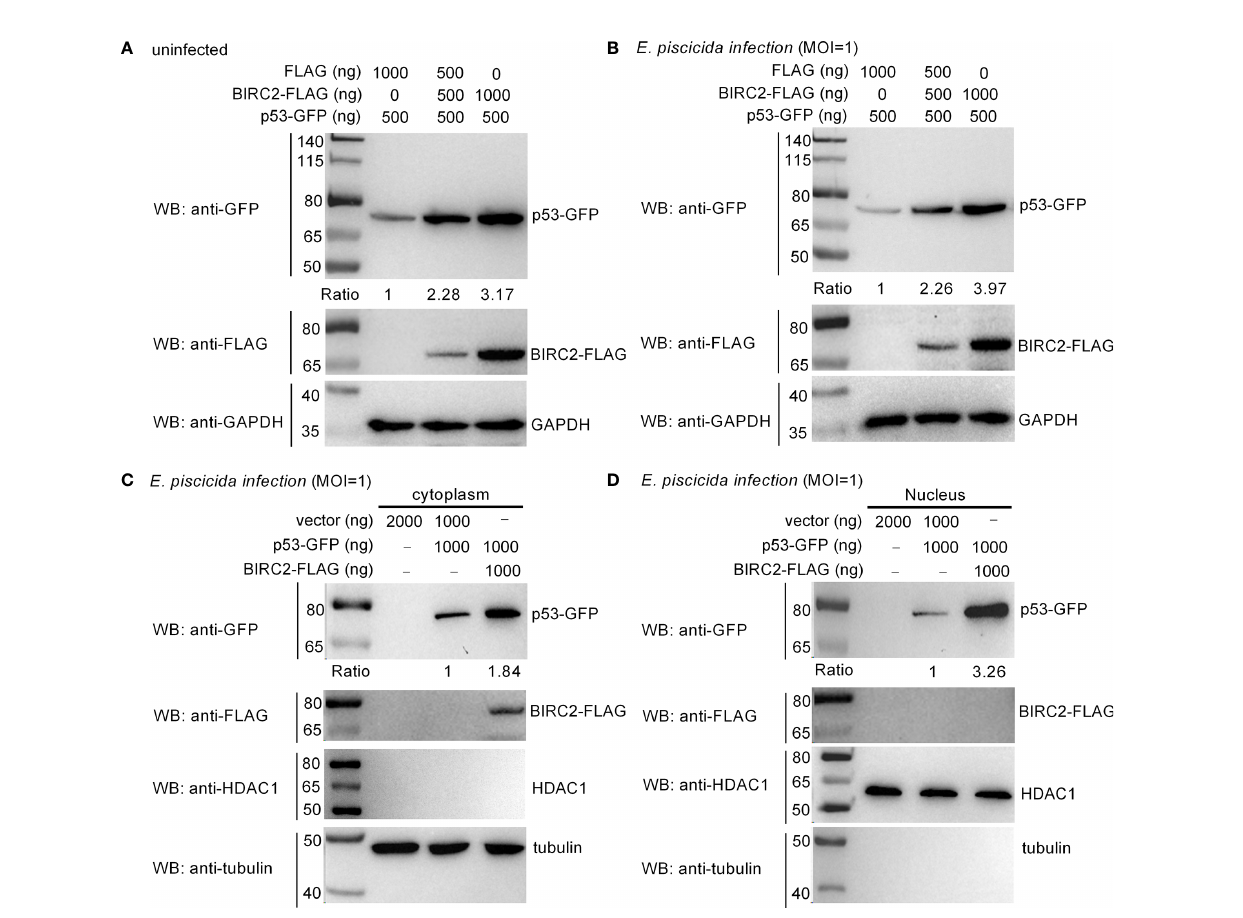
FIGURE 6 | Zebra fi sh BIRC2 accumulates p53. (A) Zebra fi sh BIRC2 accumulates p53 in the uninfected EPC cells. (B) Zebra fi sh BIRC2 accumulates p53 in the E. piscicida -infected EPC cells. (C) Zebra fi sh BIRC2 accumulates p53 in the cytoplasm of infected EPC cells. (D) Zebra fi sh BIRC2 accumulates p53 in the nucleus of infected EPC cells. For (A, B) , EPC cells transfected with p53-GFP, p3×FLAG and/or BIRC2-FLAG were infected with E. piscicida for 1 h at an MOI of 1 or left untreated. At 6 hpi, the cells were washed, lysed, and subjected to Western Blotting with the indicated antibodies. For (C, D) , EPC cells transfected with p53-GFP, p3×FLAG and/or BIRC2-FLAG were infected with E. piscicida for 1 h at an MOI of 1. At 6 hpi, the cells were harvested and used for preparation of nuclear and cytoplasmic extracts. Tubulin and HDAC1 were used as loading controls for cytoplasmic and nuclear protein, respectively. The expression ratio for p53 protein was quanti fi ed by Quantity